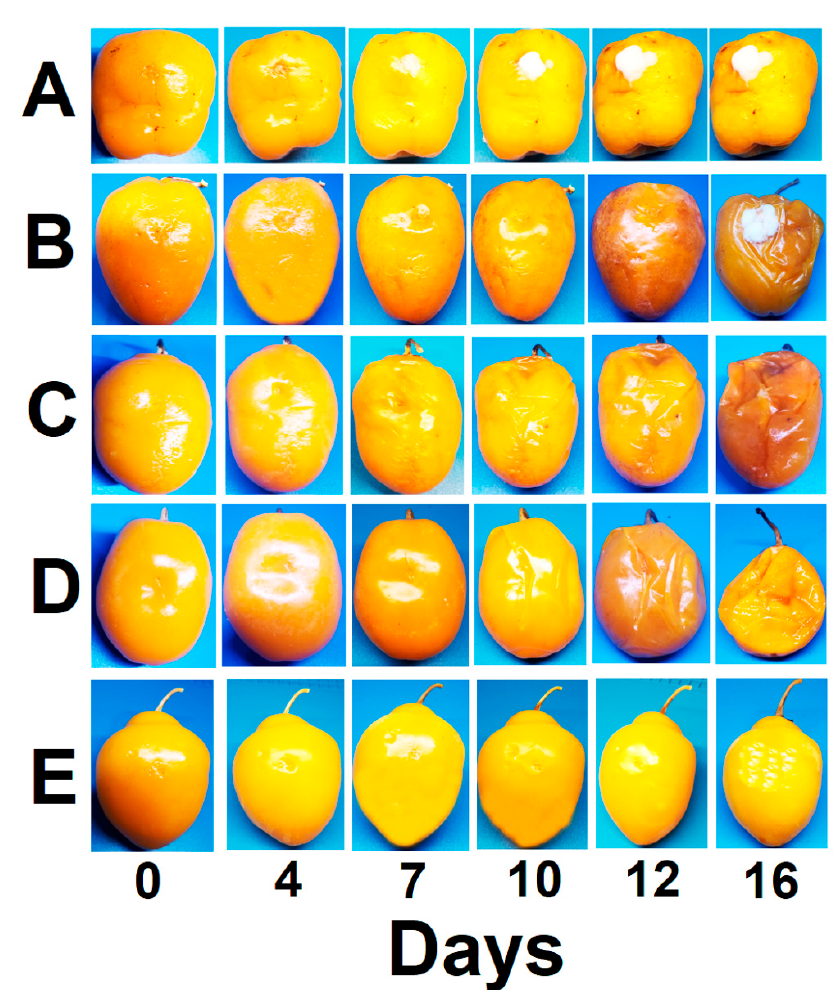
Figure 3. Kinetics for rot symptom emergence in manzano peppers infected with Fusarium temperatum ( A ). The in situ protective effect of ZlEO ( B ), 2-undecanone ( C ), 2-undecenal ( D ) and 2-dodecenal ( E ) on infected chili peppers was followed for 16 d.